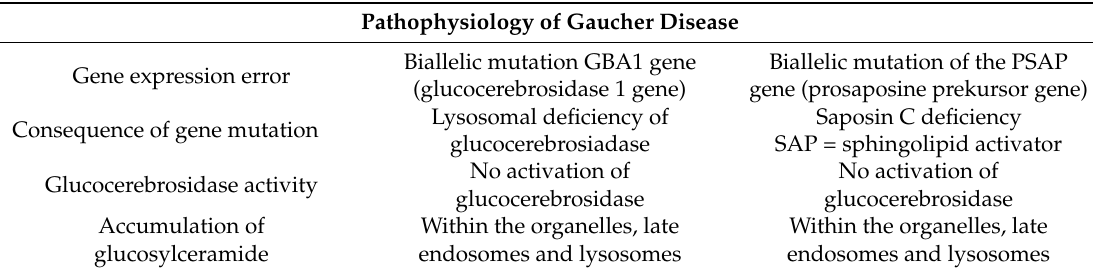
Table 1. Pathophysiology of Gaucher